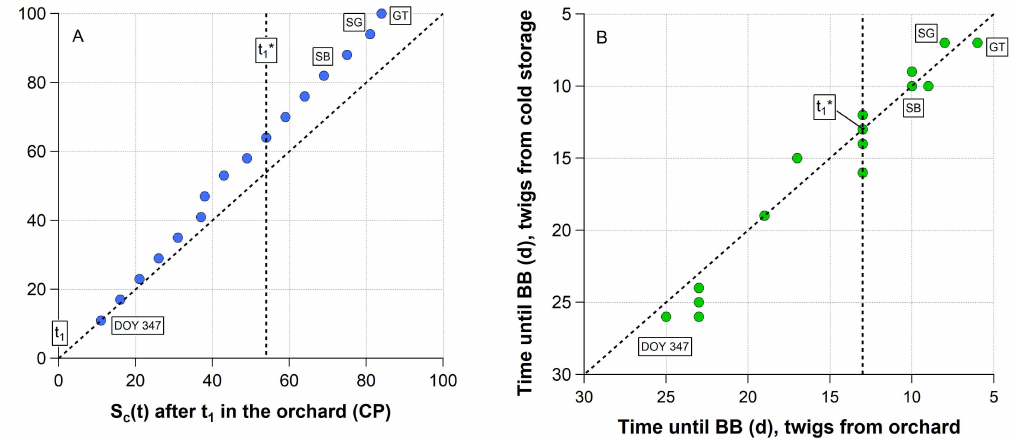
Figure 3. ( A ) Accumulated chill units after endodormancy release (t 1 ) in chill portions (CP)